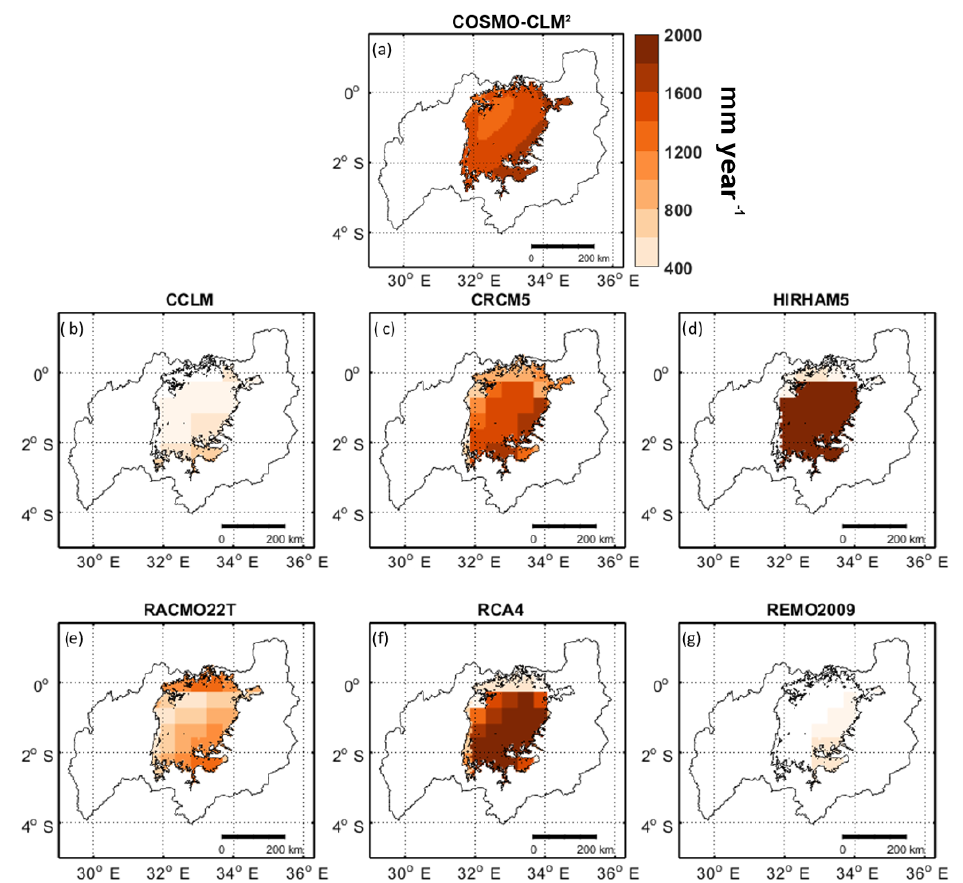
Figure 3. Annual accumulated evaporation during the period 1993–2008 as derived from COSMO-CLM 2 (a) the CORDEX evaluation simulations (b–g)